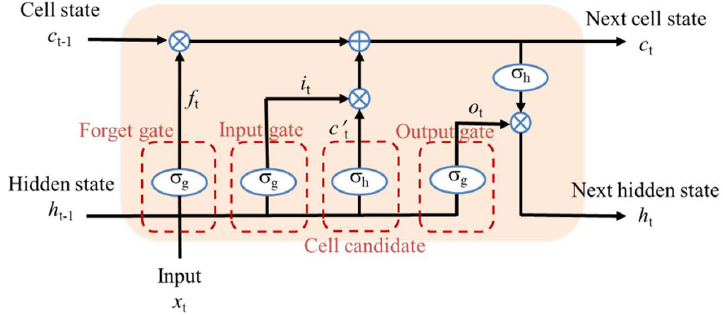
Figure 4. The typical structure of long-short term memory (LSTM). σ h and σ g denote the hyperbolic tangent and sigmoid functions, respectively.